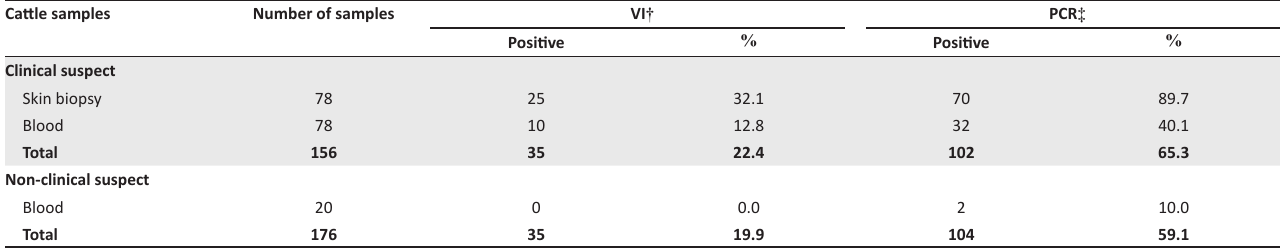
TABLE 2: Detection of lumpy skin disease virus in blood samples and skin biopsies of cattle and buffaloes. Cattle samples Number of